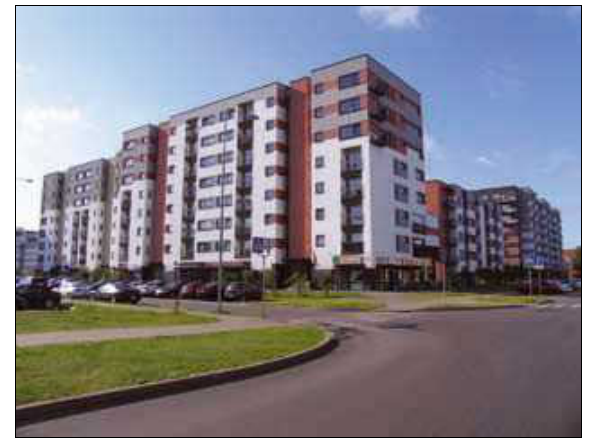
Fig. 26. r­enovation of block of flats in Žirmūnai st.